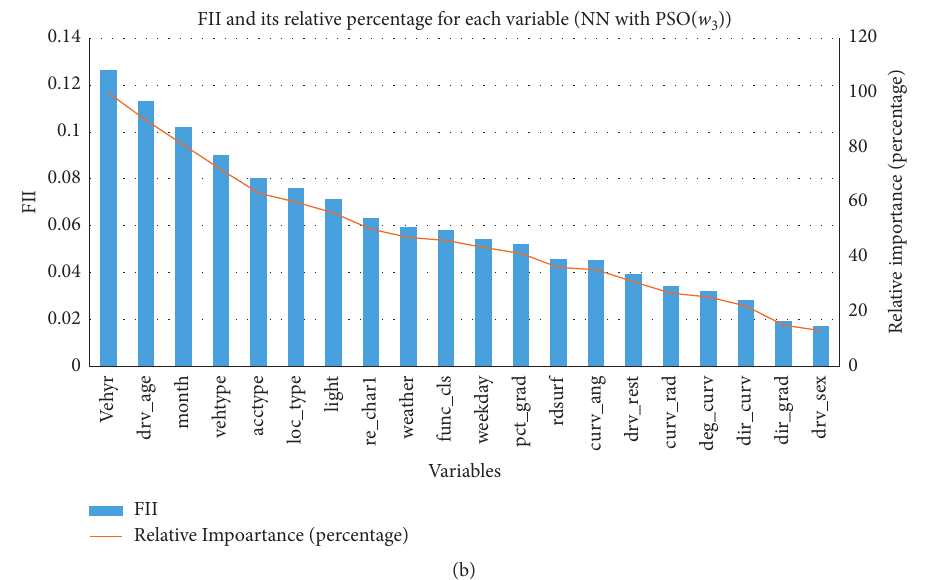
Figure 7: Summary of results for factor analysis. (a) FII and its relative percentage for each variable (NN with PSO ( w relative percentage for each variable (NN with PSO ( w